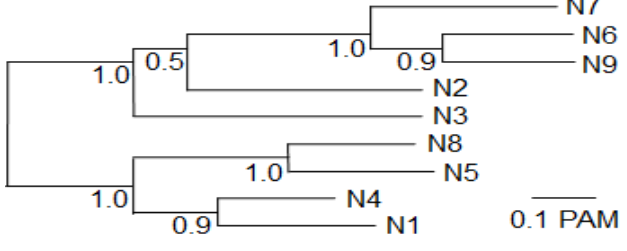
Figure 2. Phylogenetic tree of the nine influenza A virus N subtypes used in this study. The protein sequences of the complete NA of the nine strains used for recombinant NA production (Table 3) were aligned and used for phylogenetic analysis. The statistical support as measured by 100 cycles of bootstrap analysis is indicated at each node.